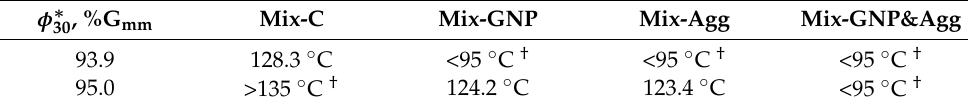
Table 3. Estimation of compaction